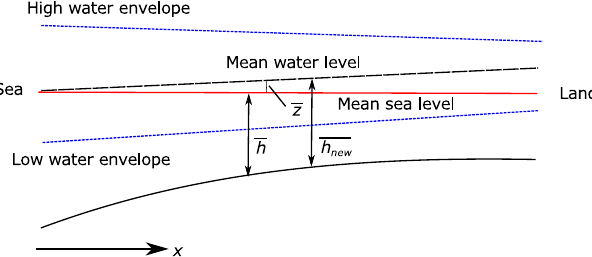
Figure 5. Sketch of the water levels in a tidal river (after Cai et al.,